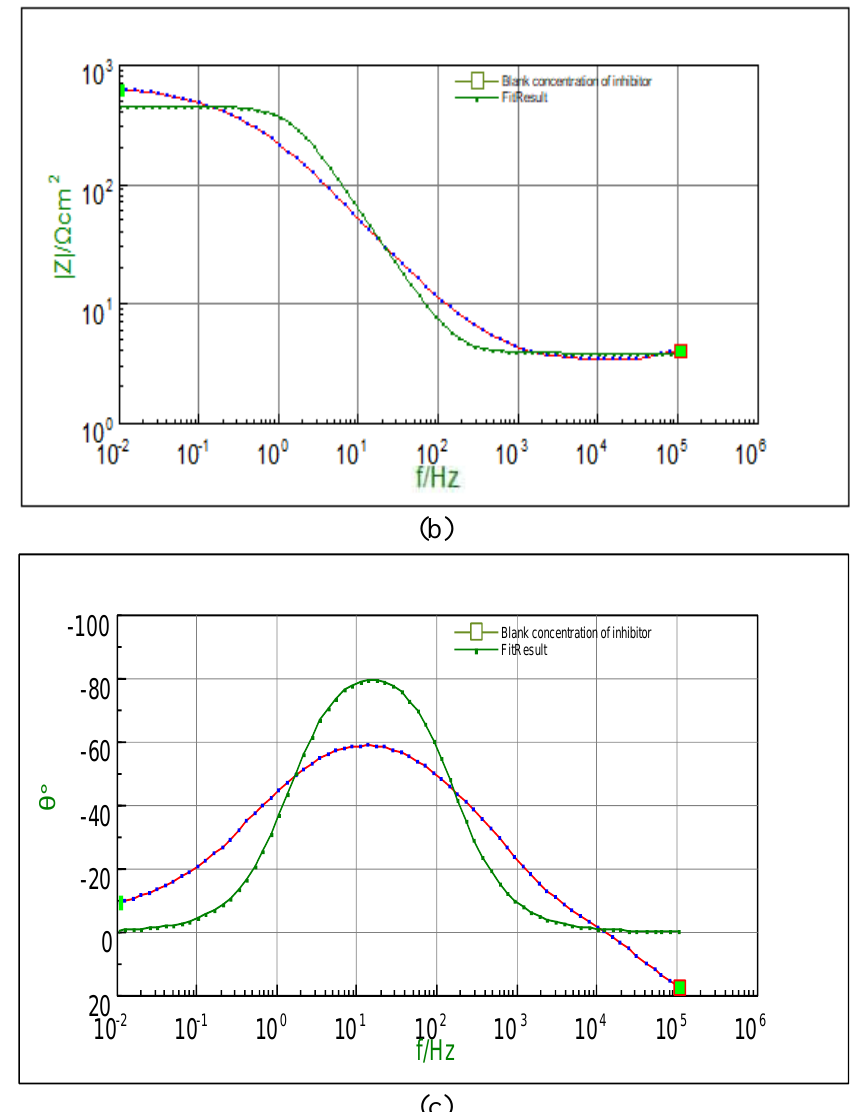
Fig. 7. The EIS test for blank concentration of inhibitor at 25◦C with the fitting result. . (a) Nyquist plot, (b, c) Bod (log versus |z|), and phase angle (log f versus ∝ 𝟎 )